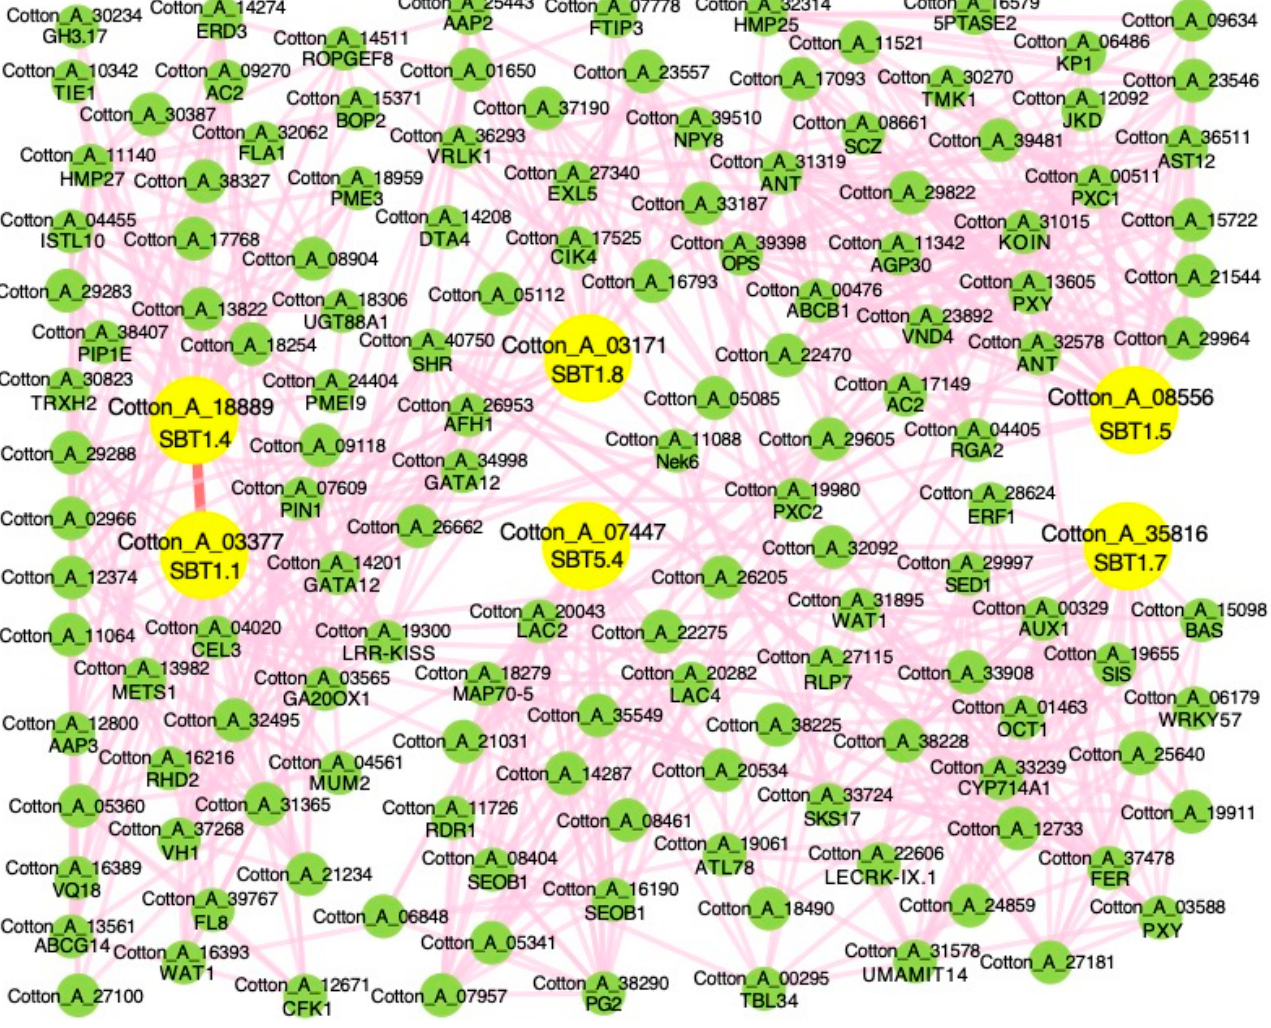
Figure 5. Gene co-expression network of six Gossypium arboreum SBT gene family members. The green nodes are co-expressed genes, and the large yellow nodes are Gossypium arboreum SBT genes. The pink line shows a co-expression relationship between two genes and the red line indicates SBT gene co-expression.